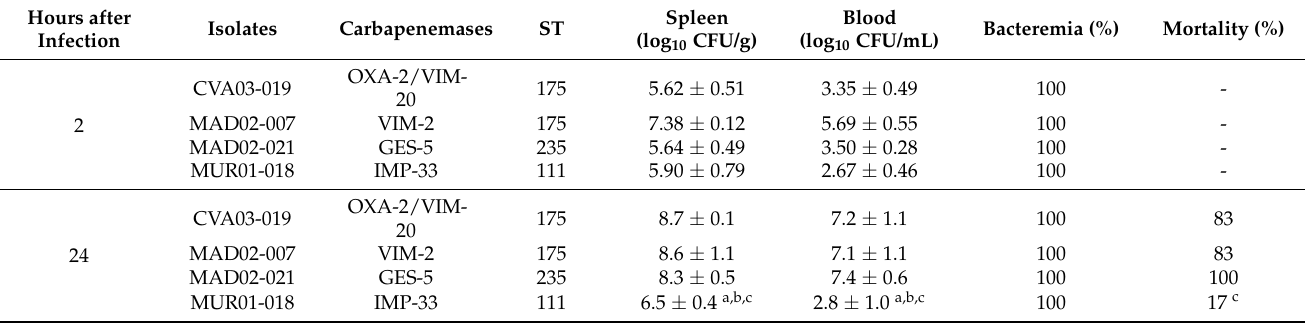
Table 2. Bacterial concentrations in spleen and blood and percentages of bacteremia in infected, untreated mice at initiation of treatment and at 24 h after infection.